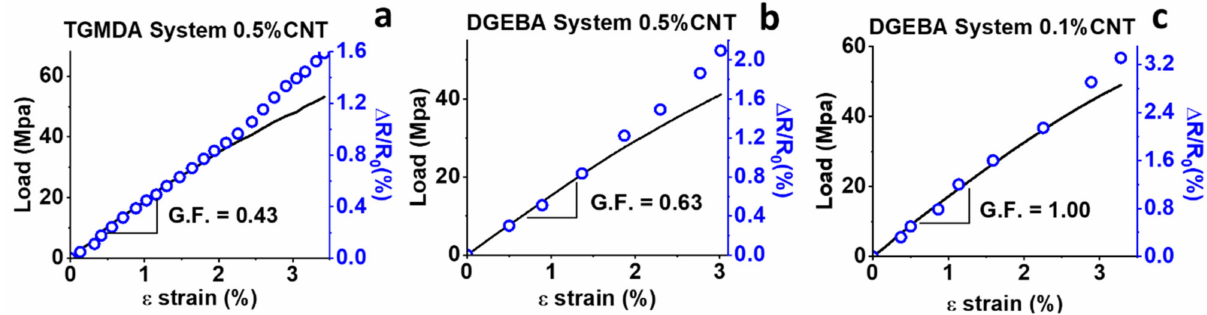
Figure 8. Mechanical response ( σ , left vertical axis) and resistance change ratio ( ∆ R/R 0 , right vertical axis) observed in tensile stress as a function of the axial strain ( ε ) of: ( a ) TGMDA system with 0.5% CNTs; ( b ) DGEBA system with 0.5% CNTs; ( c ) DGEBA system with 0.1%